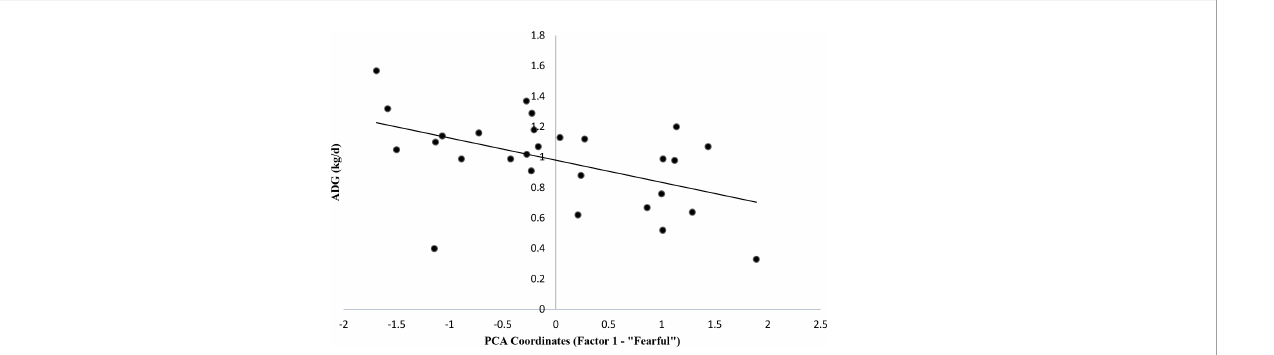
FIGURE 1 Average daily gain (ADG) of individually housed Holstein x Angus crossbred calves (n = 29) during the 76-d experimental period, plotted against Factor 1 ( “ Fearful ” ) from the principal component analysis of the standardized personality tests. Each black dot represents a calf, and the linear regression trendline is presented ( P < 0.001).